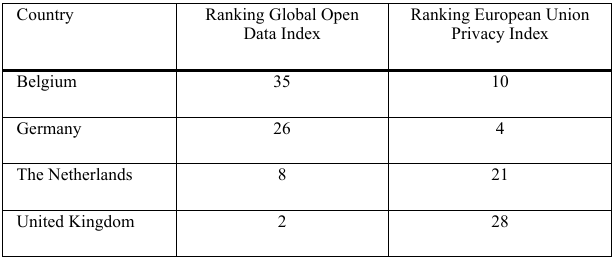
Table 1 Ranking case study countries in Open Data Index